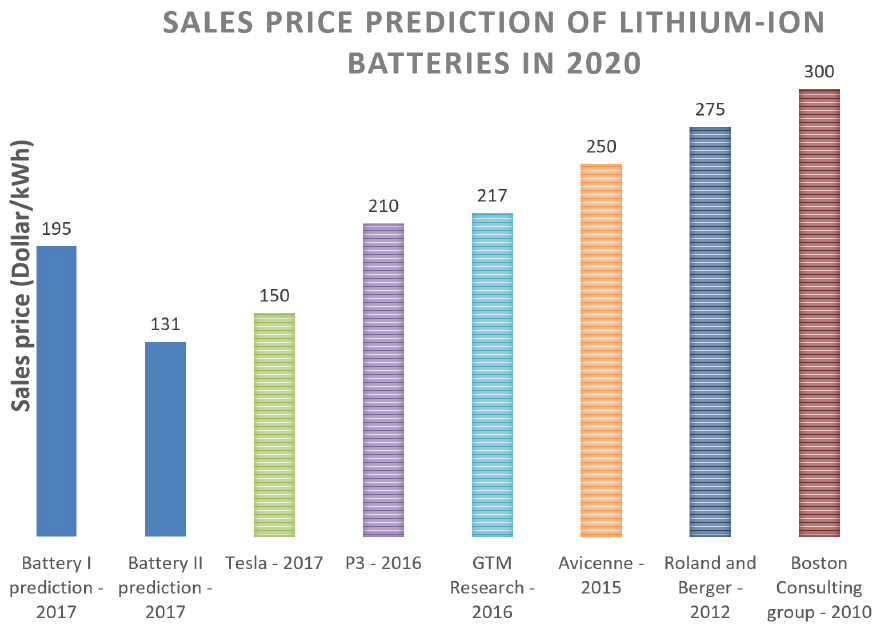
Figure 13. Sales price prediction of lithium-ion batteries in